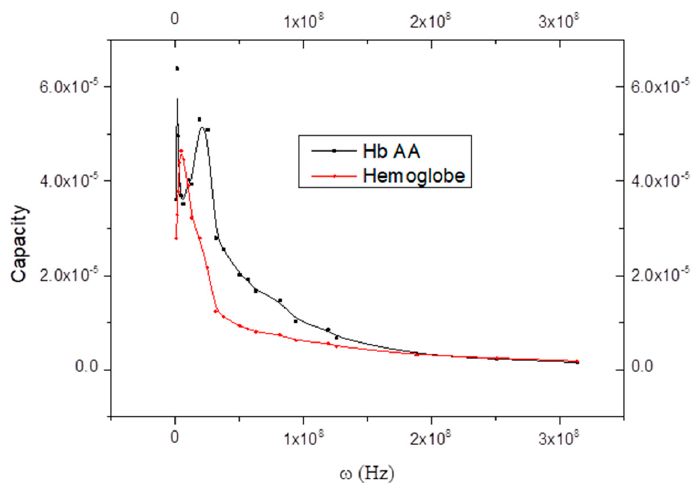
Figure 2. Comparison between HbAA (black line) and Hemoglobe (red line) capacity expressed in p-Farad (pF) calculated by Equations (30) and (31), respectively, as a function of frequency.